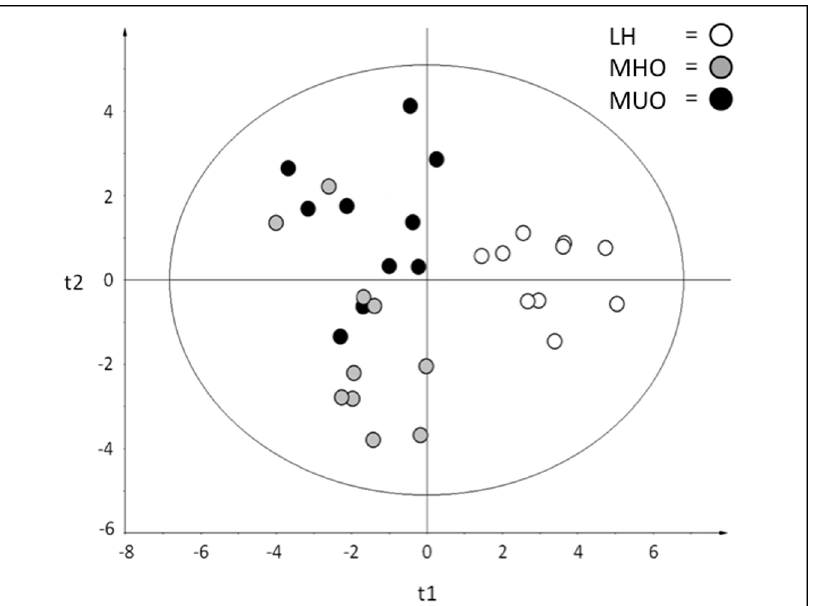
Figure 2. Orthogonal Projections to Latent Structures-Discriminatory Analysis (OPLS-DA) corresponding to the fatty acid profile from serum phospholipid and triglyceride fractions. The fatty acid (FA) profiles from serum phospholipid (PL) and triglyceride (TG) fractions (expressed as relative % values) were analyzed for their ability to distinguish lean healthy (LH), metabolically healthy obese (MHO), and metabolically unhealthy obese (MUO) individuals (n=10/group). The OPLS-DA parameters obtained revealed 58% of inter-group variability and 32% of prediction ability (R 2 Y cum =0.58, Q 2 Y cum =0.32, CV-ANOVA=0.05).